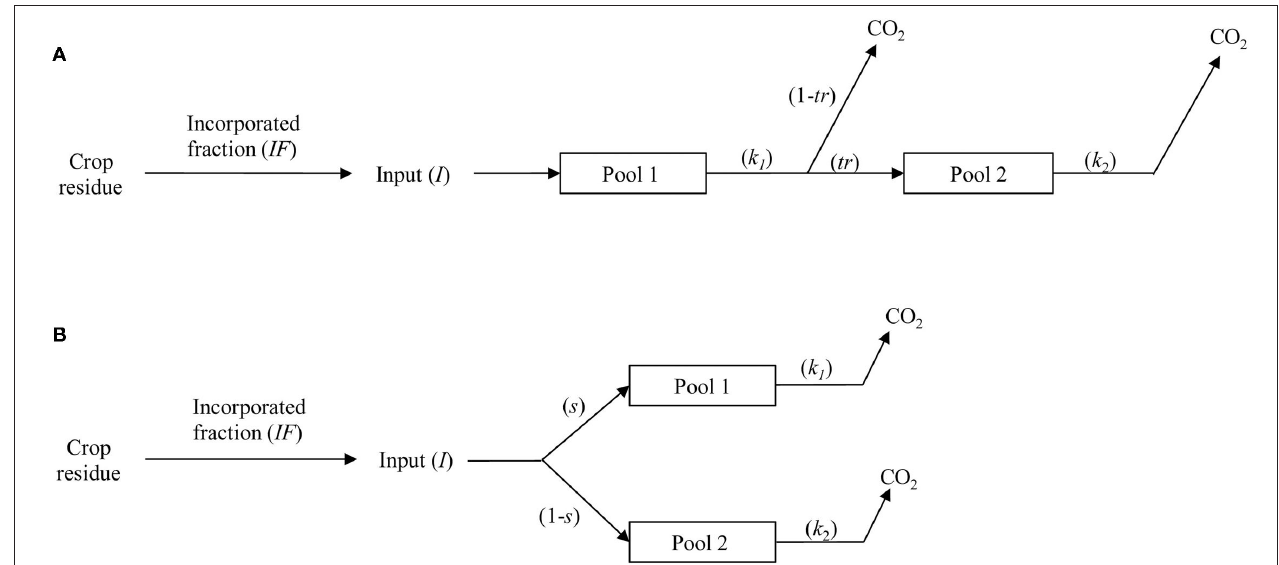
FIGURE 2 | Flow chart of the two two-pools models considered in this study for soil organic C dynamics, two sequential pools model (A) and two-parallel pools model (B) , where Pool 1 cycles more rapidly than Pool 2.